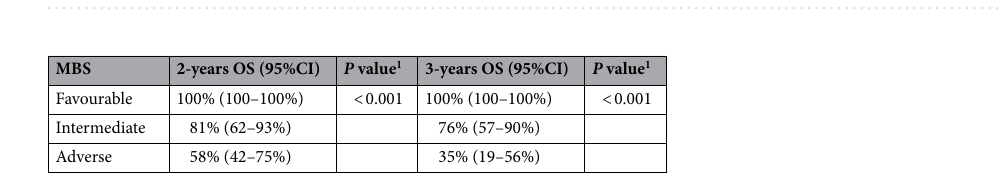
Figure 3. Molecular-Based Score (MBS) prognostic prediction in IPSS-R very-low- and low-risk patients, and distribution across all IPSS-R risk categories. ( A ) Kaplan–Meier curves of MBS on overall survival (OS) of IPSS-R very-low and low-risk myelodysplastic syndrome. ( B ) Distribution of MBS across all IPSS-R classification.